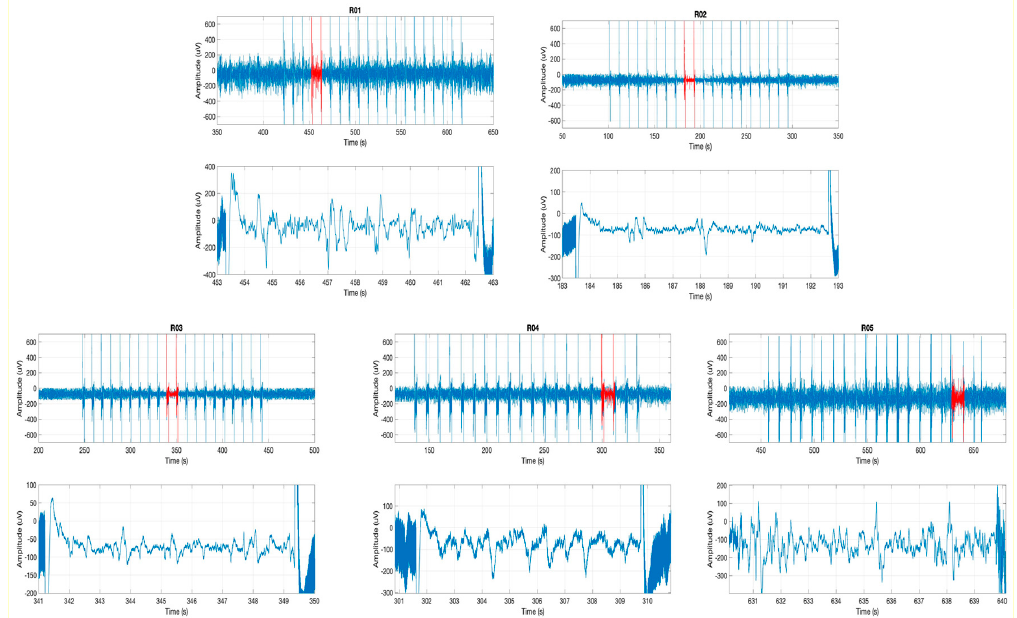
Figure 2. Electrocorticogram (ECoG) signals during stimulation from all five rats. Red landmark